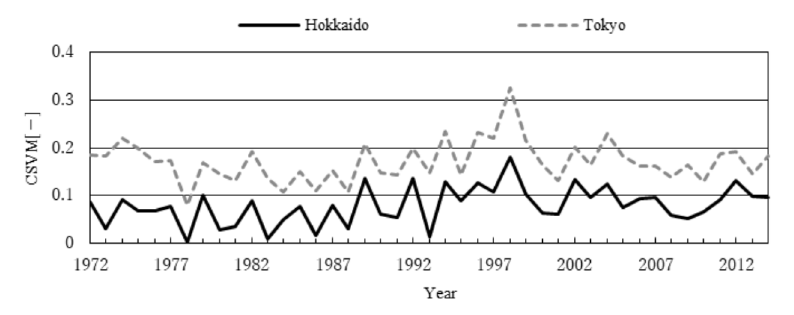
Figure 1. CSVM in Tokyo and Hokkaido.